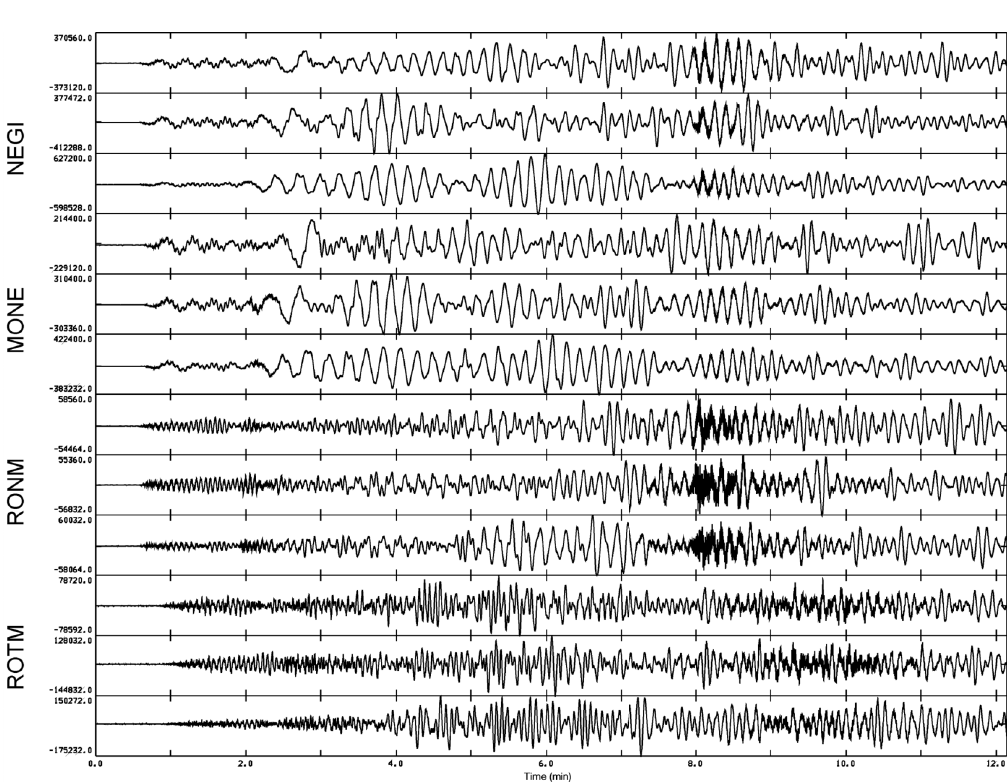
Fig. 2. Sample of the recordings of the Algerian earthquake as detected by some instruments of the RSNI net- work. NEGI and MONE are equipped with broadband